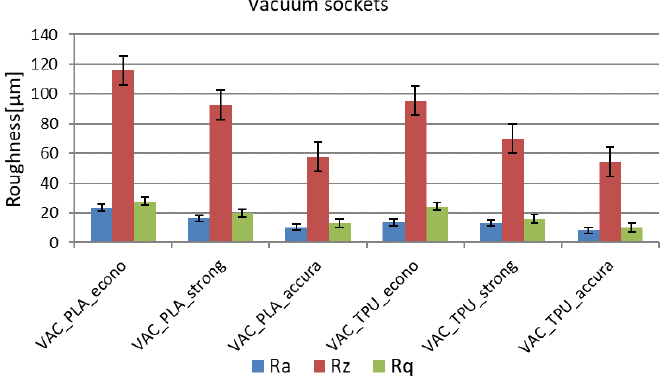
Figure 16. Roughness measurement results for the vacuum sockets.